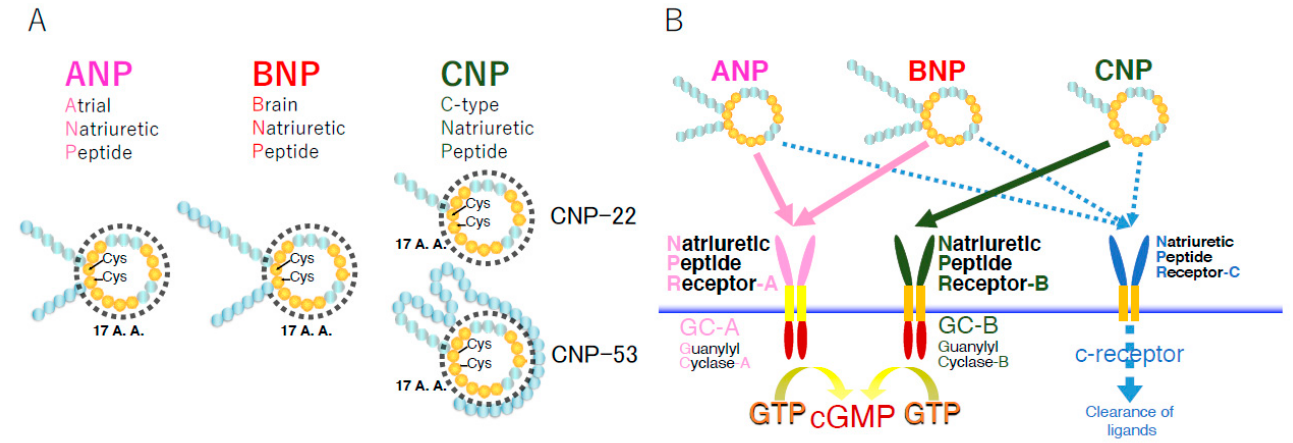
Figure 1. Schematic representation of natriuretic peptides ( A ) and their receptors ( B ). A.A.: amino acids; Cys: cysteines making the disulfide bond in each ring structure.